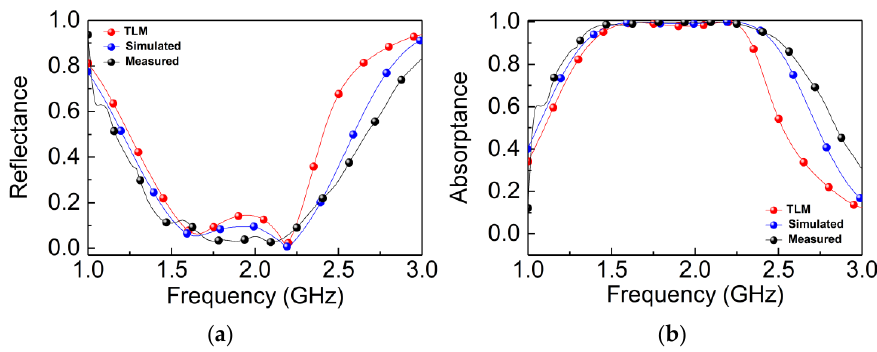
Figure 10. Simulated, measured, and TLM ( a ) reflectance and ( b ) absorptance of the proposed absorber.